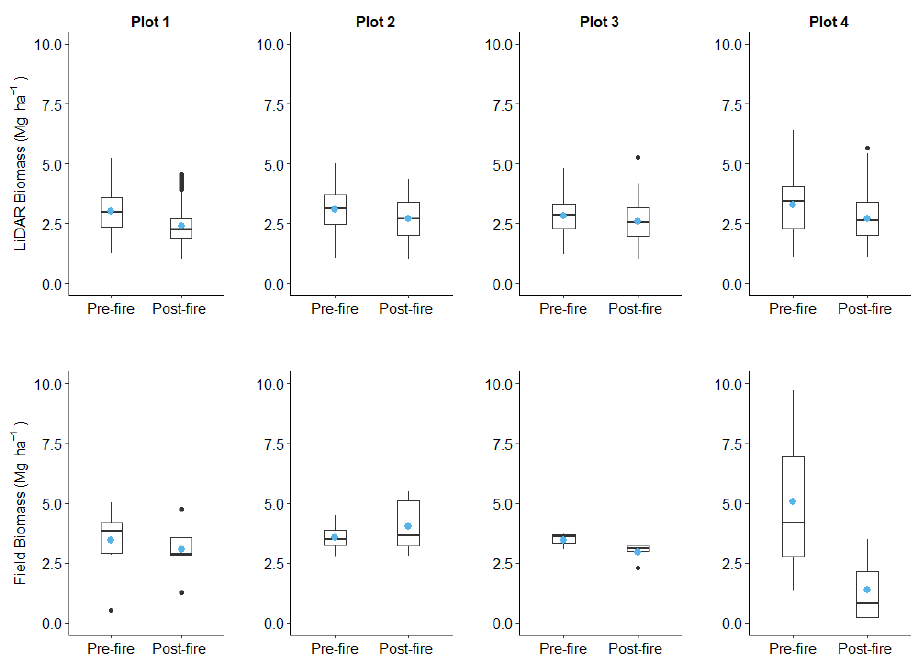
Figure 7. Pixel-scale (0.5 × 0.5 m) LiDAR-derived biomass compared to biomass-derived from field